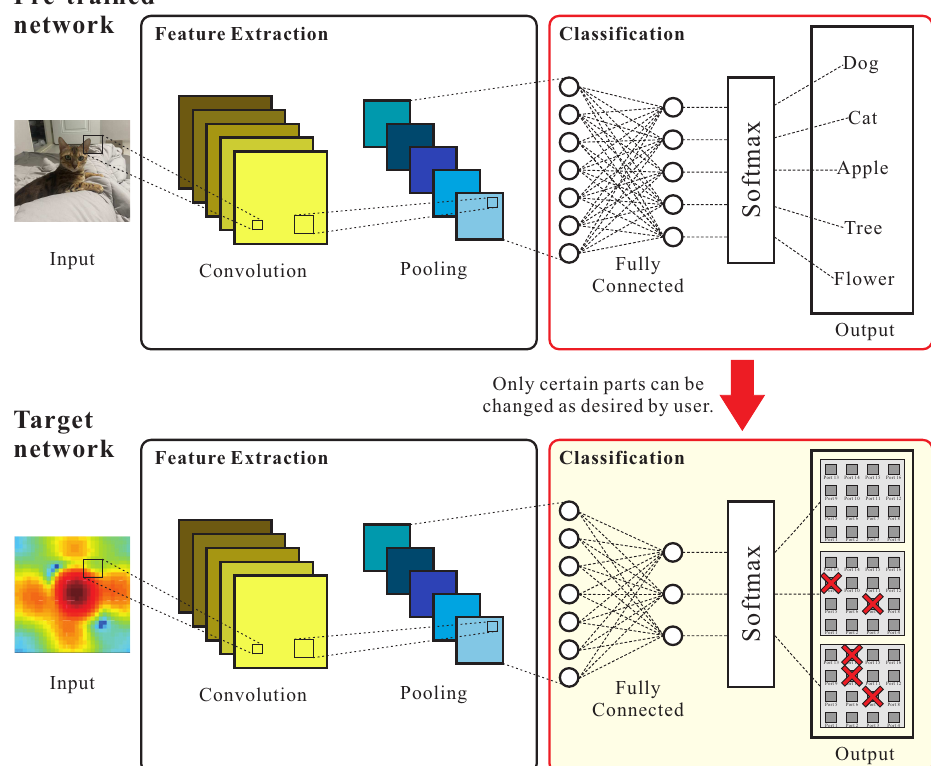
Figure 1. Concept diagram of transfer